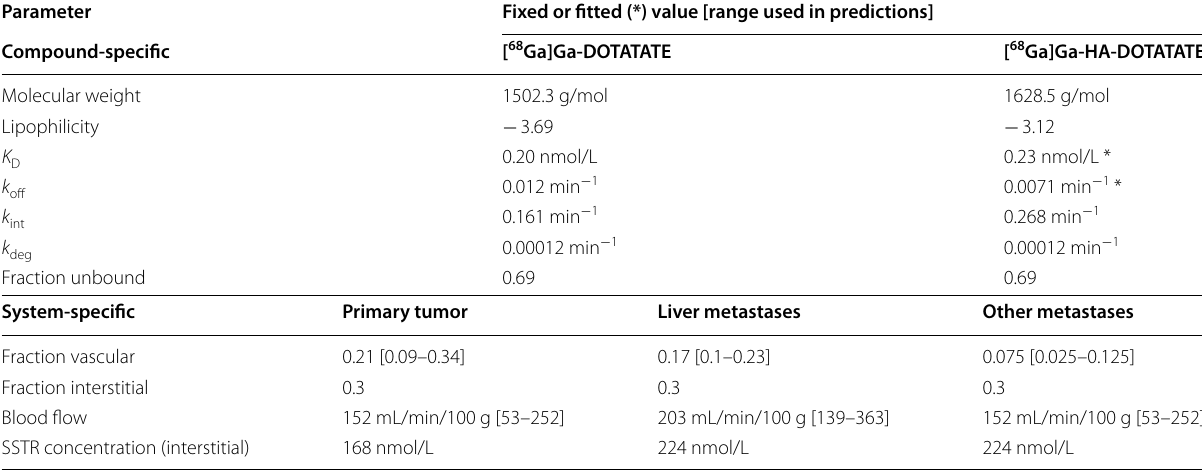
K D Equilibrium dissociation constant; k off Dissociation rate constant; k int Internalization rate; k deg Degradation rate; SSTR Somatostatin